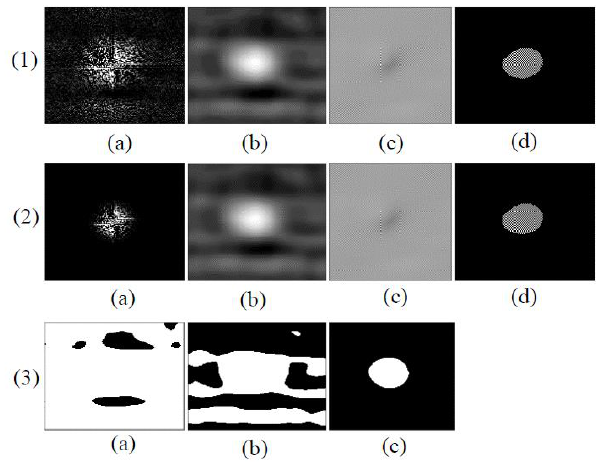
Figure 17. The total process of target segmentation using (1) Fourier transform and Wavelet transform, followed by multi-thresholding and erosion, (2) Fourier transform and Gaussian, followed by multi-thresholding and erosion, ( a ) Fourier transforms, ( b ) inverted Fourier transforms (magnitude), ( c ) inverted Fourier transforms (phase), and ( d ) segmented results, and (3) a fuzzy c-mean algorithm with, ( a ) a threshold value of 0.206500, ( b ) a threshold value of 0.211538, and ( c ) a threshold value of 0.480769.